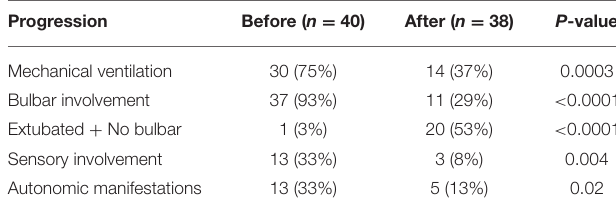
TABLE 2 | Comparison between clinical condition before vs. after initial treatment.